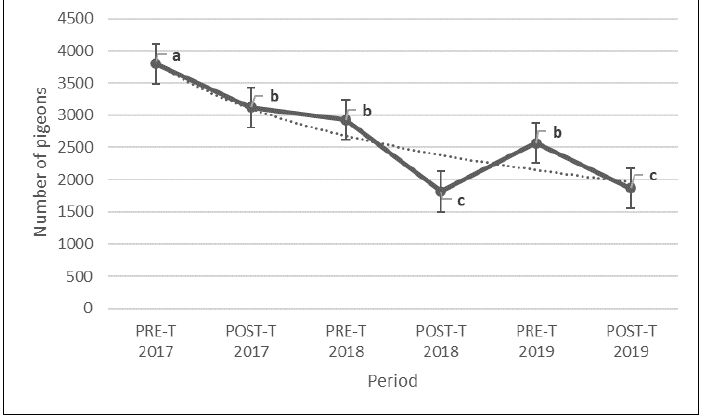
Table 3. Results of the post hoc tests (Tukey test) of the registered population trend among treat- ment periods.